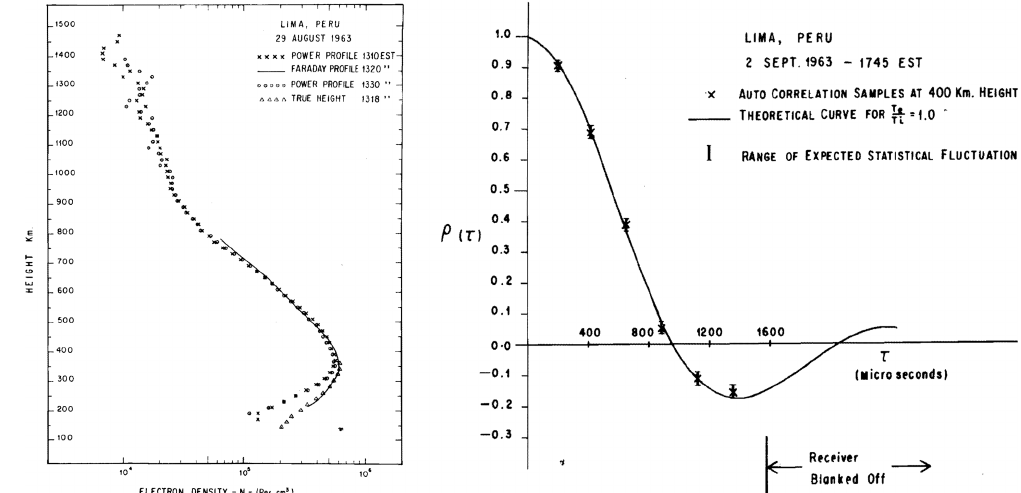
Figure 19. In the left panel is a comparison of Faraday, scaled power, and true-height electron density profiles taken in the afternoon of 29 August 1963. We can notice that the effect of T e /T i greater than 1 at the lower heights. In the right panel are an example of incoherent scatter autocorrelation measurements and the fit to a theoretical function. We can observe the good agreement between the data and the theory (adapted from Bowles, 1963b).